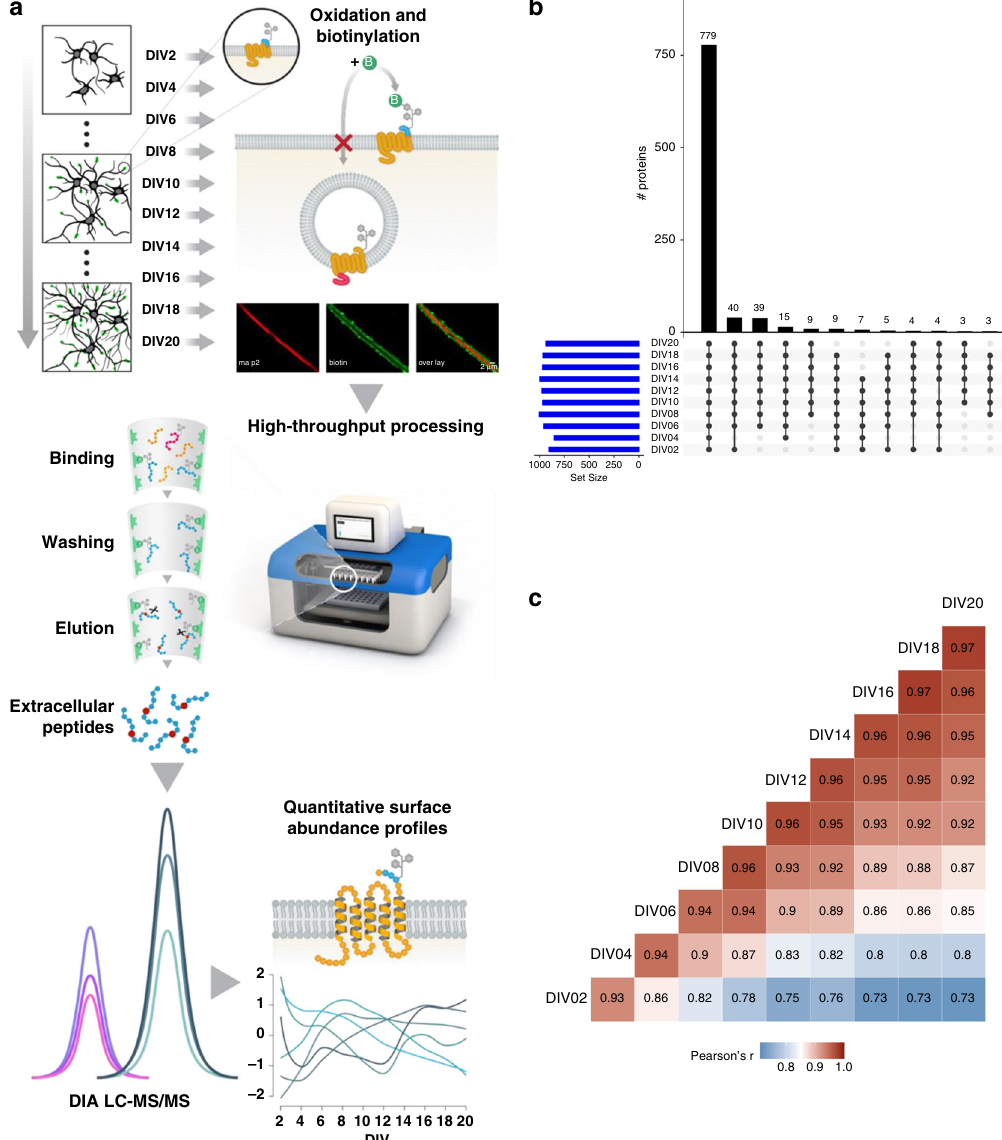
Fig. 1 Quantitative analysis of the neuronal surface using autoCSC. a Cultured cortical neurons were collected every second day from 2 to 20 DIV and subjected to autoCSC surface labeling. Live cells were oxidized under mild conditions with sodium-meta-periodate and subsequently labeled with cell- impermeable biocytin-hydrazide. After cell lysis and tryptic digestion, the resulting peptides were subjected to automated processing on a liquid handling robot. Repeated aspiration through fi lter tips containing streptavidin resin captures biotinylated N -glycopeptides. After extensive washing, peptides were released using PNGase F, which catalyzes the cleavage of asparagine-linked glycans. Cleavage leaves a modi fi cation (deamidation) at asparagines that can be identi fi ed using high-resolution MS. Initially labeled and extracellular peptides are identi fi ed by presence of deamidated asparagines within the NXS/T glycosylation consensus sequence, indicating both surface localization and glycosylation site. DIA and targeted feature extraction were used to quantify surface-protein abundances across multiple conditions, providing quantitative surface abundance pro fi les across neuronal development in culture. b Qualitative overview of the neuronal surfaceome composition illustrated by intersections of quanti fi ed proteins for each time point. c Correlation of all quanti fi ed protein abundance values per DIV (median per time point). Source data are provided as a Source Data fi